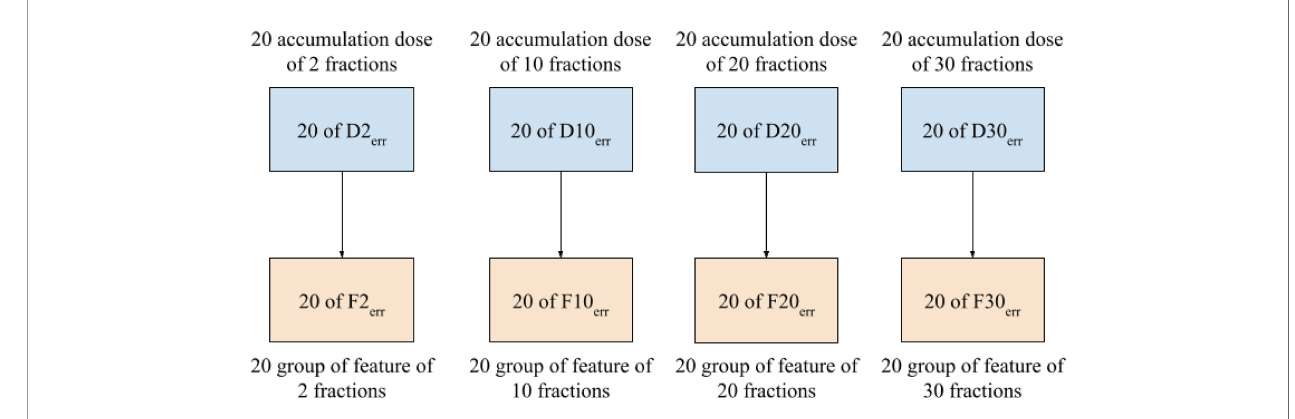
FIGURE 3 | Total of 80 groups of features extracted from D err for